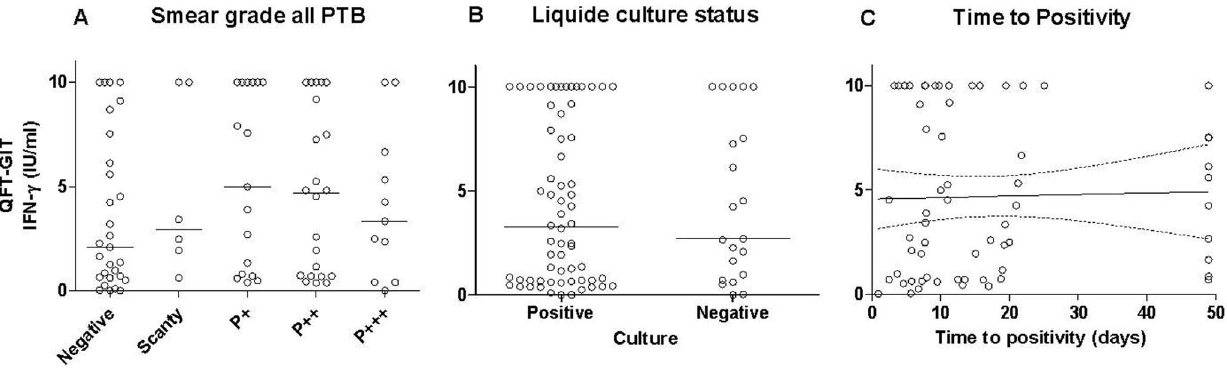
Figure 3. Relationship between individual quantitative IFN- c results (IU/ml) and the sputum bacillary load expressed as (A) smear grade (p=0.64), (B) liquid culture results (p=0.83), and (C) time-to-positivity (TTP) of the liquid culture (R 2 =0.00082, p=0.82), measured in the active pulmonary tuberculosis patients with interpretable IFN- c results (indeterminate excluded). Short bars, median level of QFT-GIT response in each group. Abbreviations: IFN- c : interferon- c .